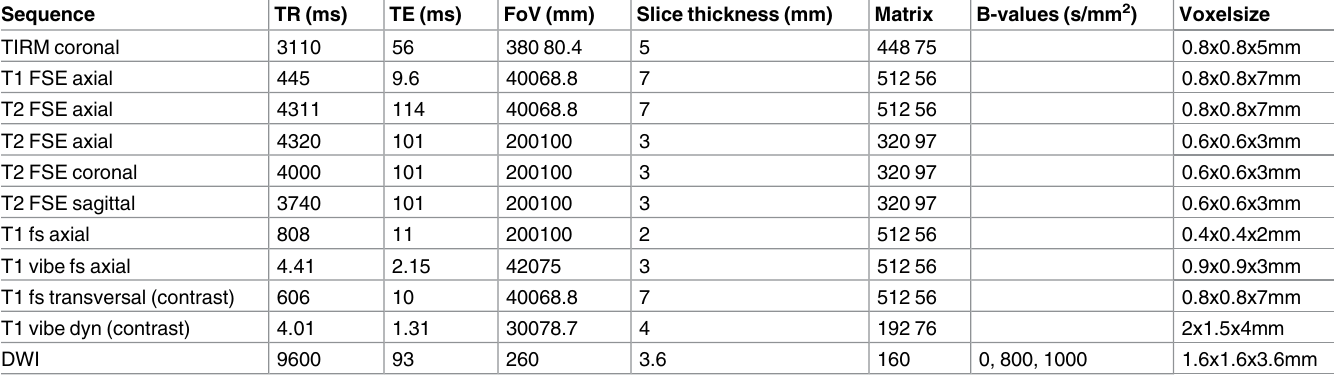
Table 2. MR imaging sequence